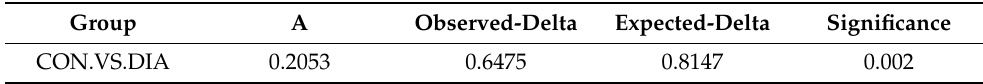
Table 2. MRPP analysis of intestinal microbial of rabbit colon.